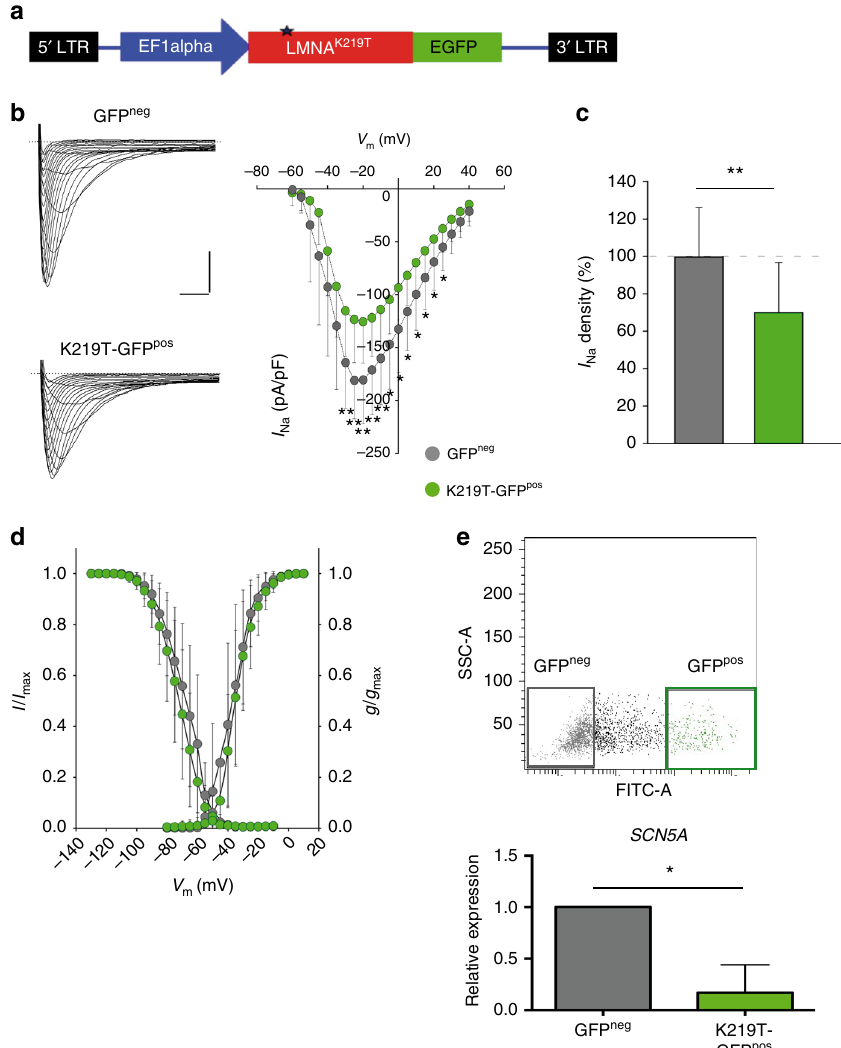
Fig. 8 K219T-LMNA overexpression in RUES2-CMs reproduces phenotypes of K219T-CMs. a Lentiviral vector expressing the C-terminal GFP-tagged K219T-Lamin A/C used for lentiviral particle production. b Analysis of sodium current ( I Na ) densities in CMs differentiated from the human embryonic stem cell line RUES2 and transduced with lentiviral particles expressing K219T-LaminA/C-GFP. Left column: examples of I Na traces recorded in GFP neg (top) and GFP pos CMs (bottom) (Scale bar, 2 ms, 50 pA/pF). Right panel: I-V curves constructed from average peak sodium current density as a function of voltage command measured in GFP neg and GFP pos CMs. (GFP neg : n = 14; GFP pos : n = 21), showing signi fi cant Na + current reductions in GFP pos